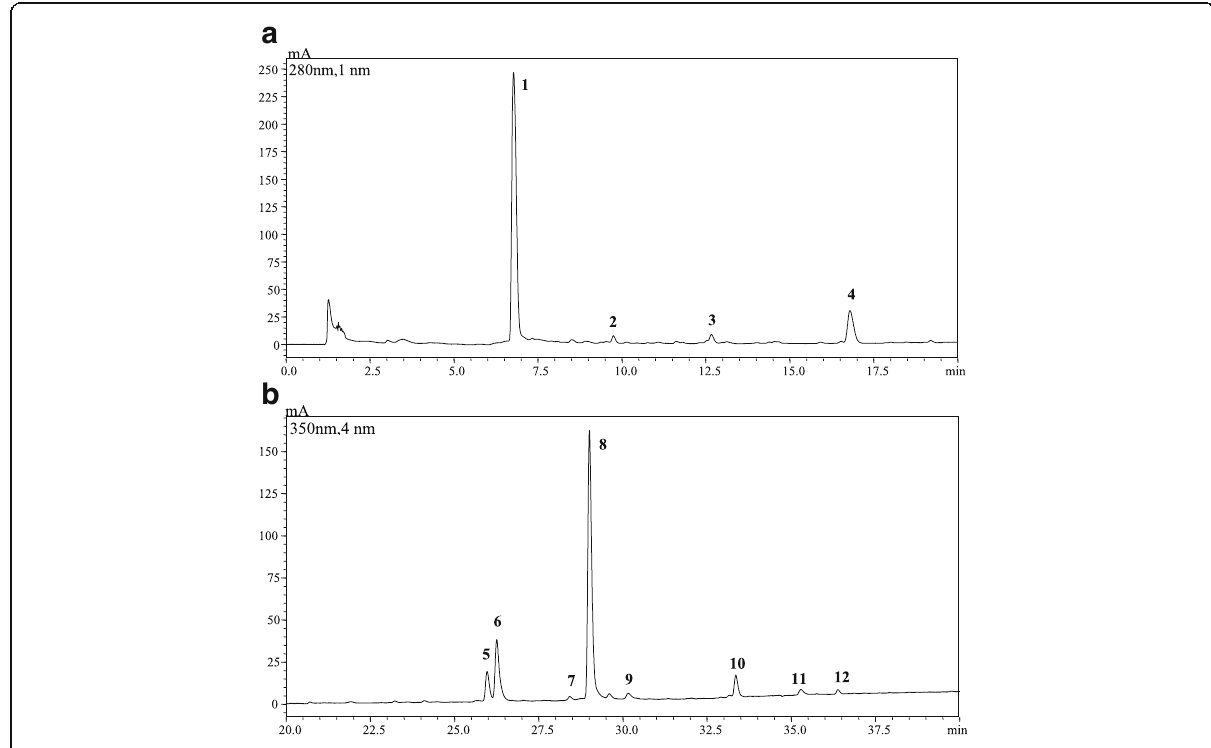
Fig. 1 HPLC-PDA chromatograms of the phenolic compounds, extracted at 280 nm ( a ) and 350 nm ( b ) wavelengths, of F. vasta leaves hydroalcoholic extract. For peak identification, see Table